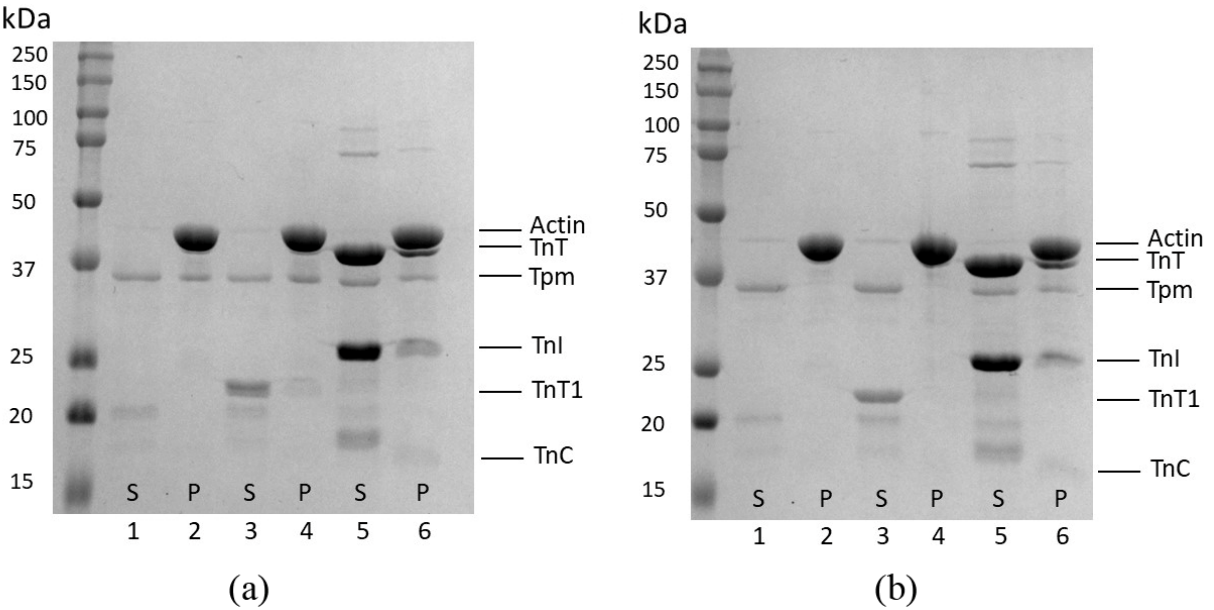
Figure 7. Tpm WT ( a ) and Tpm M8R mutant ( b ) affinities to F-actin in the presence of TnT1 fragment and Tn-complex (with EGTA). Results obtained by co-sedimentation assay. S—supernatants after centrifugation, P—pellets after centrifugation. Lanes 1–2: supernatants (1) and pellets (2) of actin sedimented with Tpm alone; lanes 3–4: supernatants (3) and pellets (4) of actin co-sedimented with Tpm and TnT1; and lanes 5–6: supernatants (5) and pellets (6) of actin co-sedimented with Tpm and whole human cardiac Tn complex.